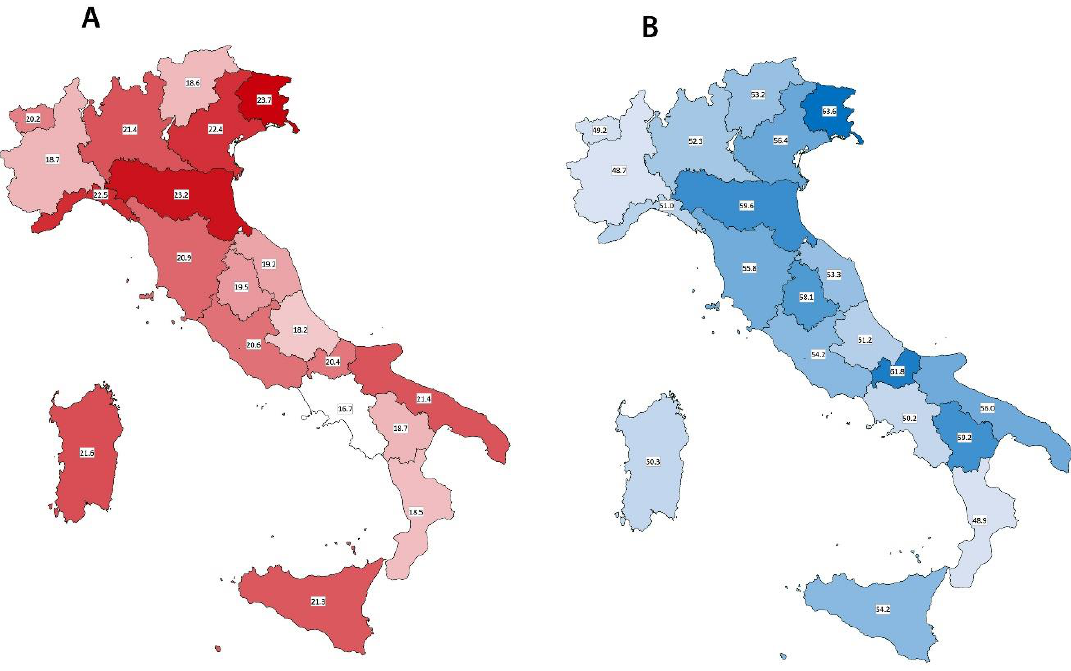
Figure 1. ( A ) Vaccination coverage according to the different Italian regions in respondents aged ≥ 18 years. ( B ), vaccination coverage according to the different Italian regions in respondents aged ≥ 65 years.